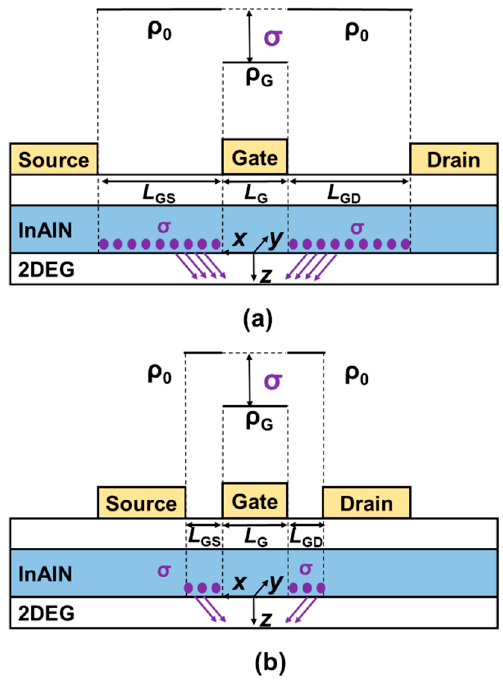
Figure 11. Schematic of the additional polarization charge ( σ ) distribution in InAlN barrier with ( a ) large and ( b ) small source–drain spacing L SD . The gate length is fixed. Figure 12a,b present the µ versus V GS for the devices with L SD of 1 μ m and L G of 50, 100, 150 nm with 8 nm and 5 nm InAlN. The electron mobility of all devices presents an